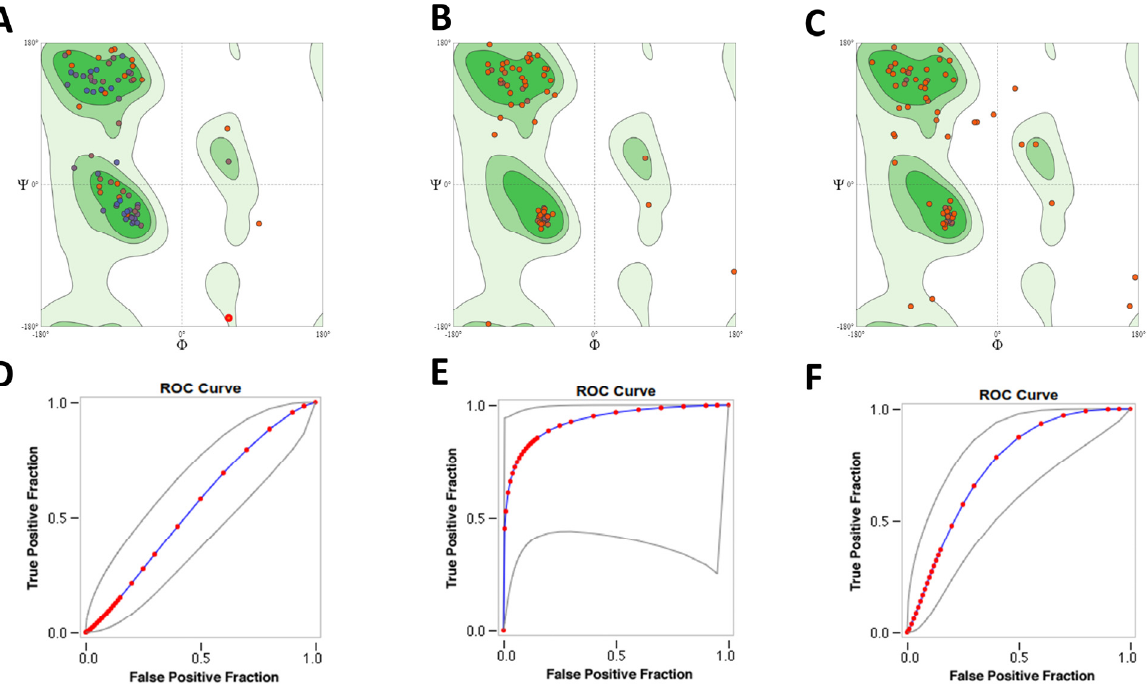
Figure 1. Evaluation of selected Lmj_04_BRCT models. Ramachandran plots for: ( A ) SwissModel_2; ( B ) Mult1_lr; ( C ) Mult1_lig. SwissModel_2 and Mult1_lr contained 92.31% of its amino acids in the favored regions, whereas Mult1_lig contained 75.00% of its amino acids in the favored regions. Receiver-operator curves for docking to models: ( D ) Swiss- Model_2, ( E ) Mult1_lr, and ( F ) Mult1_lig.